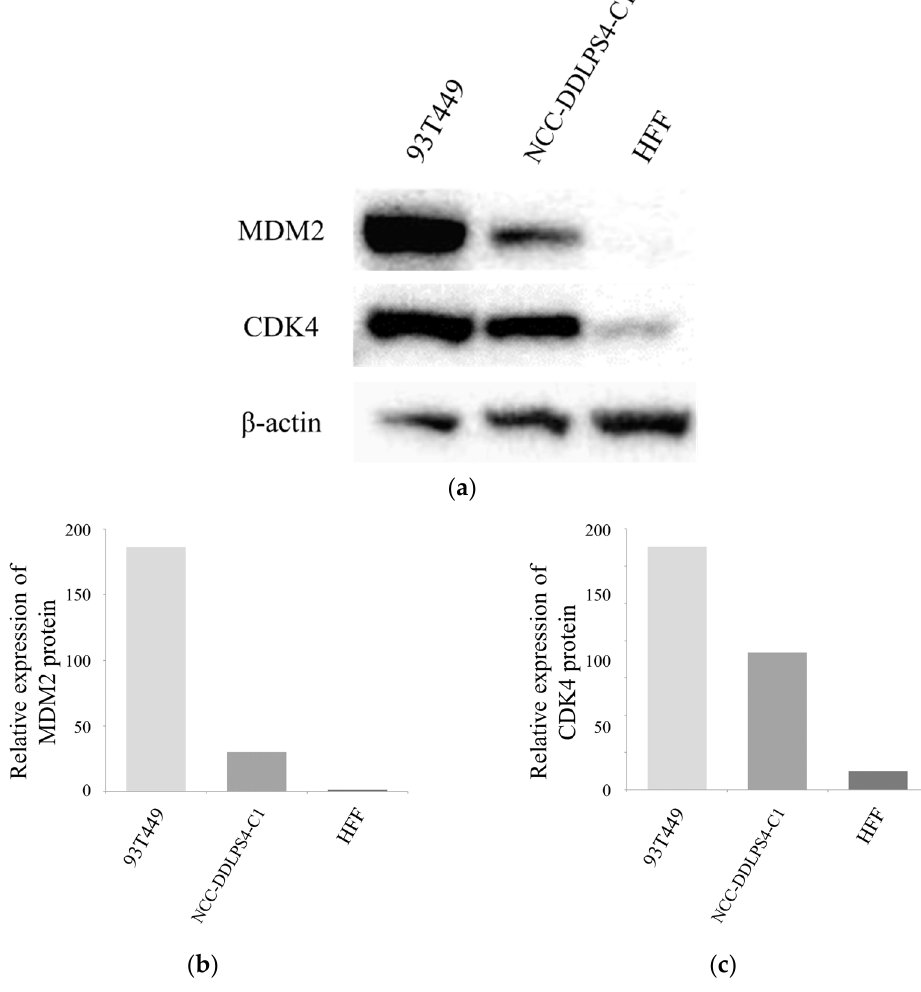
Figure 3. Western blot analysis. ( a ) NCC-DDLPS4-C1 cells with MDM2 and CDK4 overexpression; ( b , c ) relative expressions of MDM2 and CDK4, respectively.